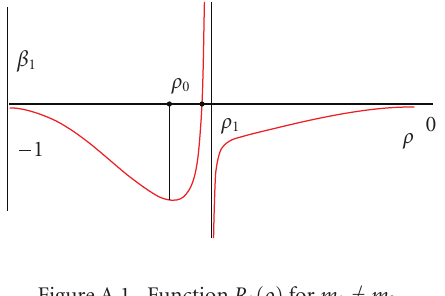
Figure A.1. Function R 1 ( ρ ) for m 1 (cid:9)= m 2 .